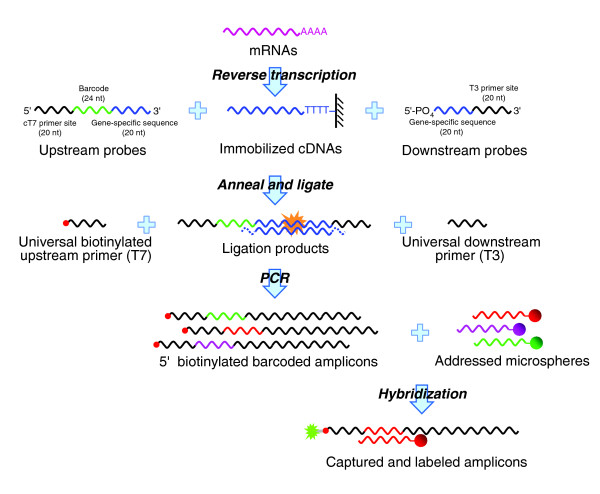
Method overview. Transcripts are captured on immobilized poly-dT and reverse transcribed. Two oligonucleotide probes are designed against each transcript of interest. The upstream probes contain 20 nt complementary to a universal primer (T7) site, one of 100 different 24 nt barcode sequences, and a 20 nt sequence complementary to the 3'-end of the corresponding first-strand cDNA. The downstream probes are 5'-phosphorylated and contain a 20 nt sequence contiguous with the gene-specific fragment of the upstream probe and a 20 nt universal primer (T3) site. Probes are annealed to their targets, free probes removed, and juxtaposed probes joined by the action of ligase to yield synthetic 104 nt amplification templates. PCR is performed with T3 and 5'-biotinylated T7 primers. Biotinylated barcoded amplicons are hybridized against a pool of 100 sets of optically addressed microspheres each expressing capture probes complementary to one of the barcodes, and incubated with streptavidin-phycoerythrin to label biotin moieties fluorescently. Captured labeled amplicons are quantified and beads decoded by flow cytometry. nt nucleotides.